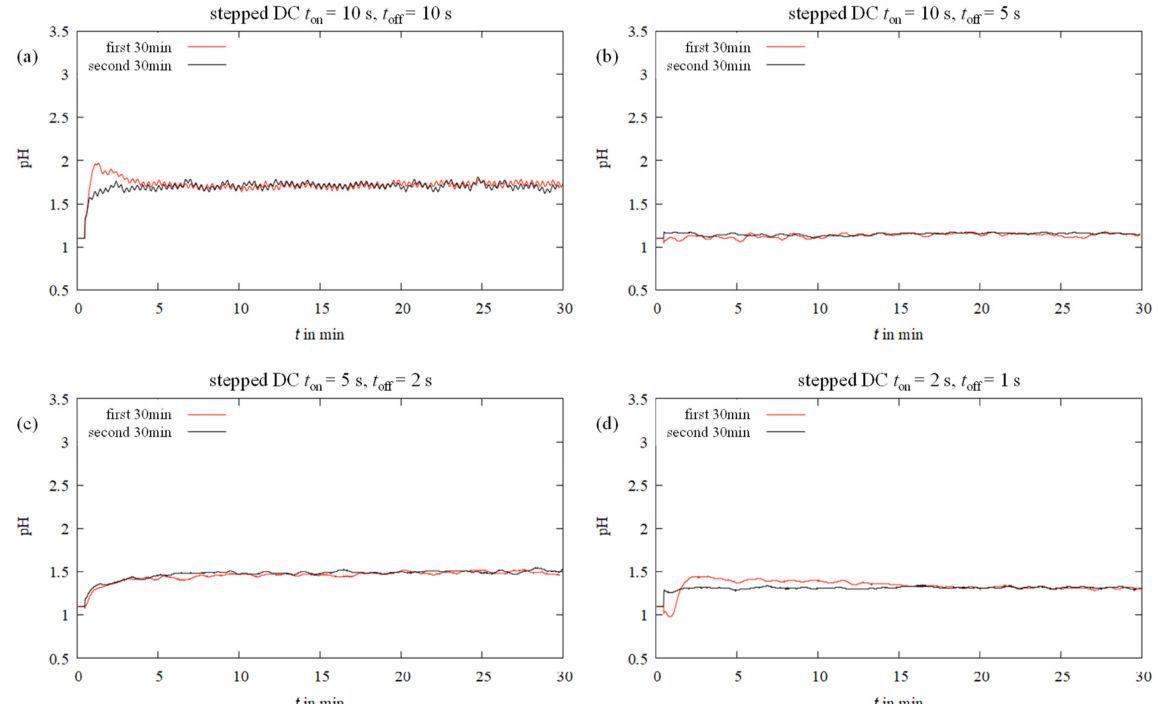
Figure 5. Near-surface pH in Fe-Cr-Ni electrolyte (fresh: first 30 min, used: second 30 min) over a pe- riod of 30 min for different DC current steps at 12 A/dm 2 . ( a ) depositions with stepped DC t on = 10 s, t off = 10 s; ( b ) depositions with stepped DC t on = 10 s, t off = 5 s; ( c ) depositions with stepped DC t on = 5 s, t off = 2 s; ( d ) depositions with stepped DC t on = 2 s, t off = 1